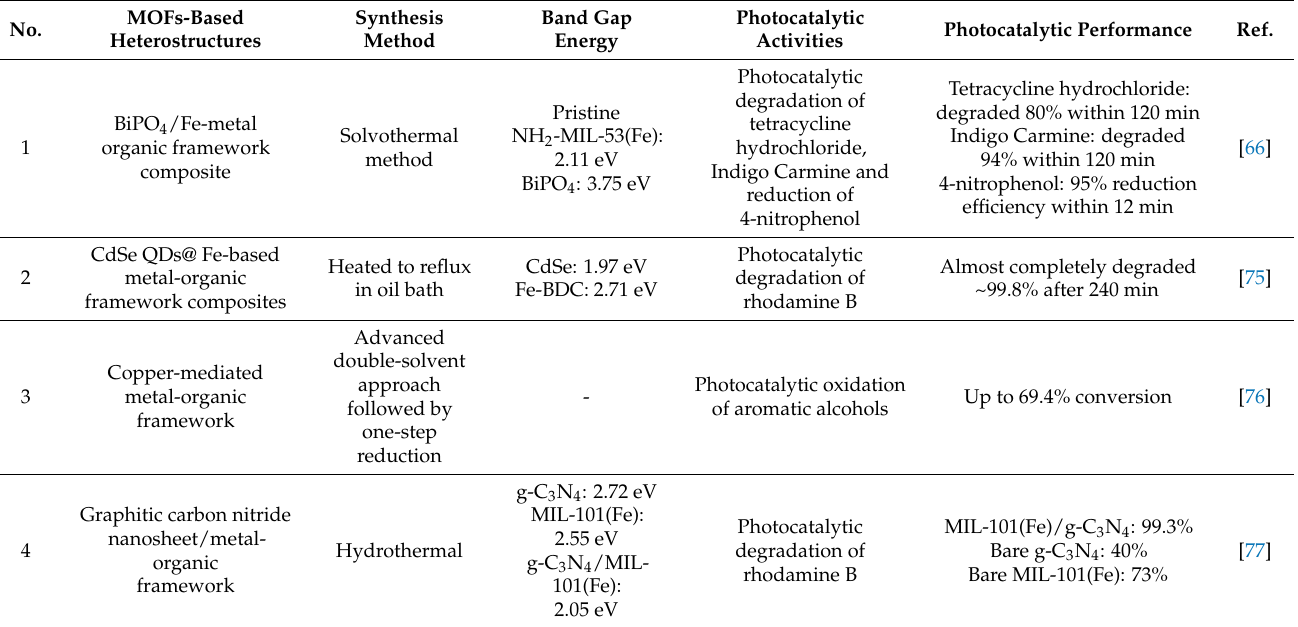
Table 2. Different modifications of